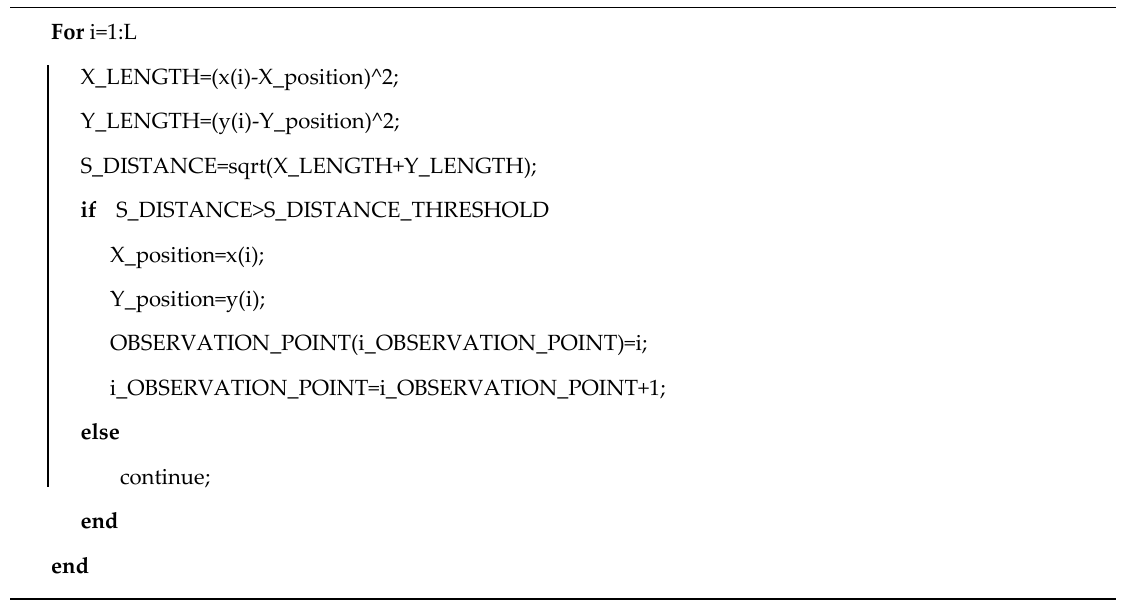
Algorithm 1. Extraction of Observations.